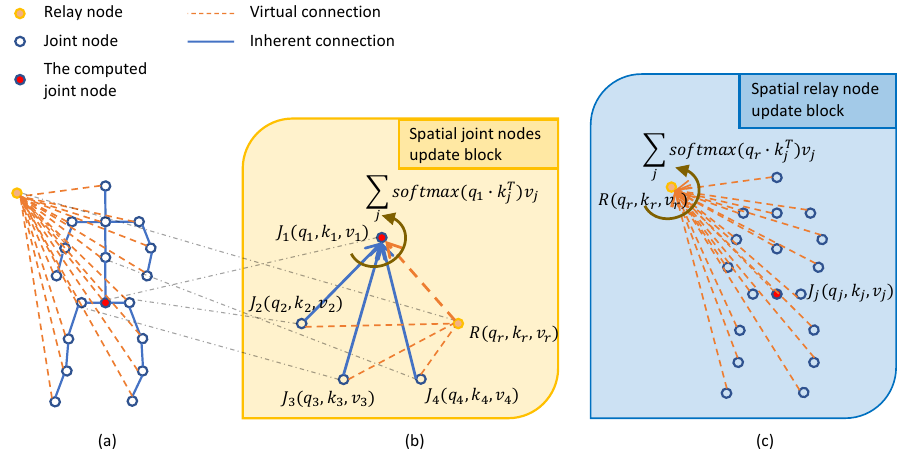
Figure 4. Illustration of the update blocks in a spatial relative transformer (SRT). The graph structure in SRT is described in ( a ). Updating operates on each joint node by obtaining local information from adjacent joint nodes and non-local information from the spatial-relay node in ( b ). Spatial-relay nodes are updated by scoring the contribution of each node, including spatial joint nodes and the spatial-relay node in ( c